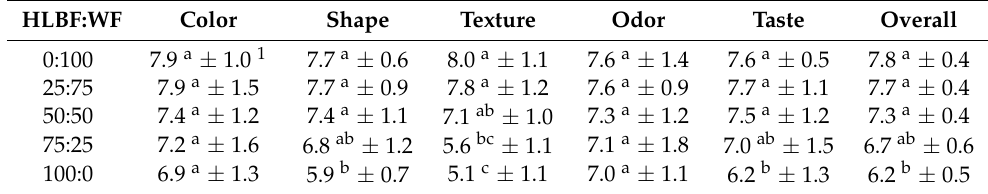
Table 6. Sensory scores of composite cookies containing wheat flour (WF) and hulless barley flour